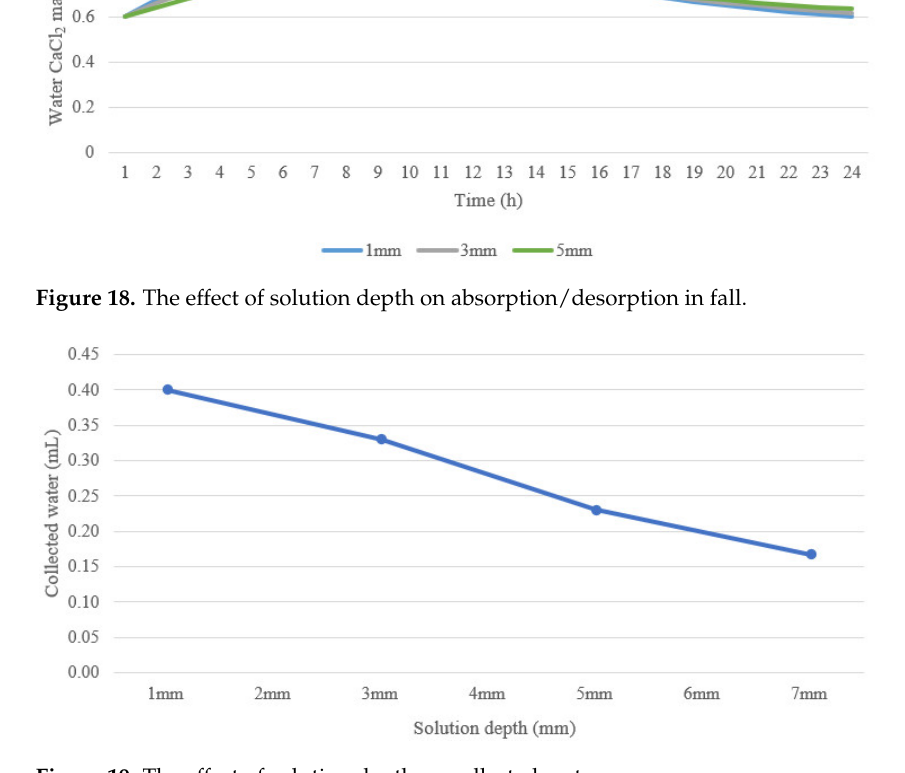
Figure 18. The effect of solution depth on absorption/desorption in fall.